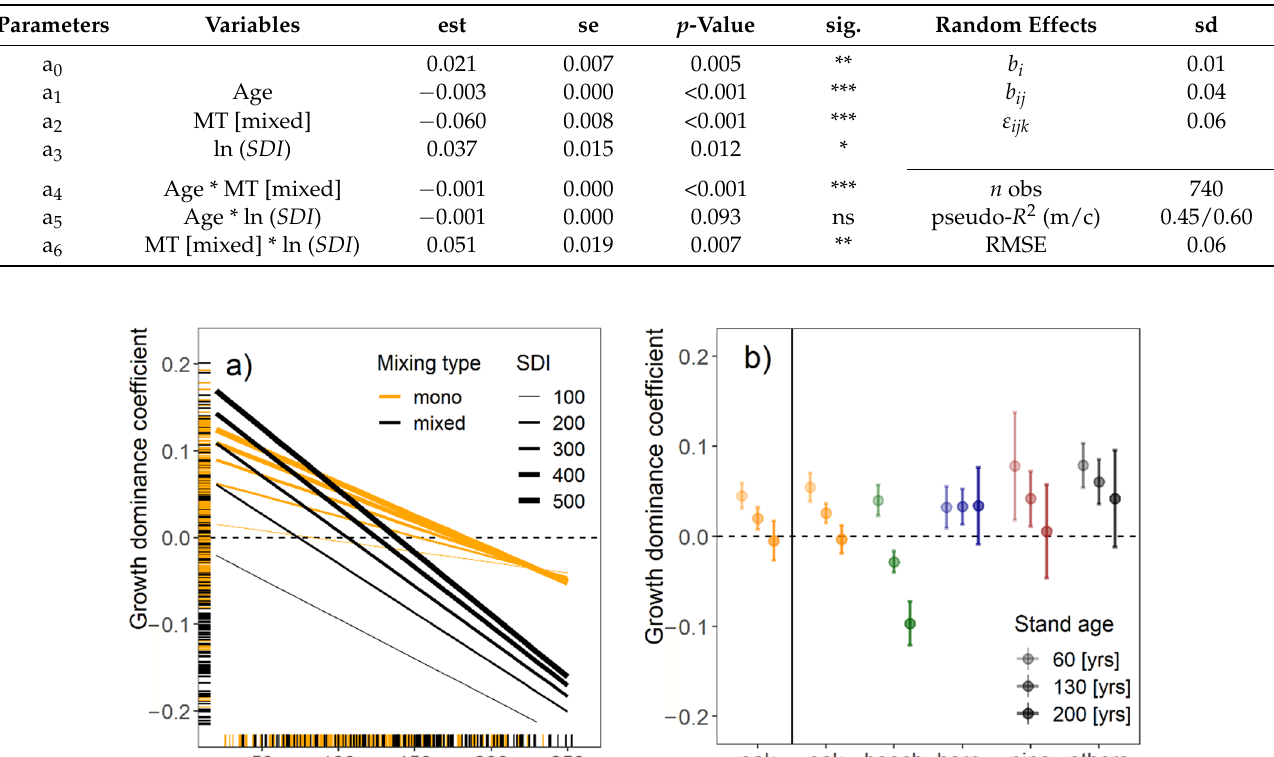
Table 7. Results of the linear mixed effects model on the Growth dominance coefficient (Equation (11)); est—estimates, se—standard errors, p -values and significance levels *** <0.001, ** <0.01, * <0.05, ns for the fixed effects; sd—standard deviations are shown for the random effects; n obs—number of